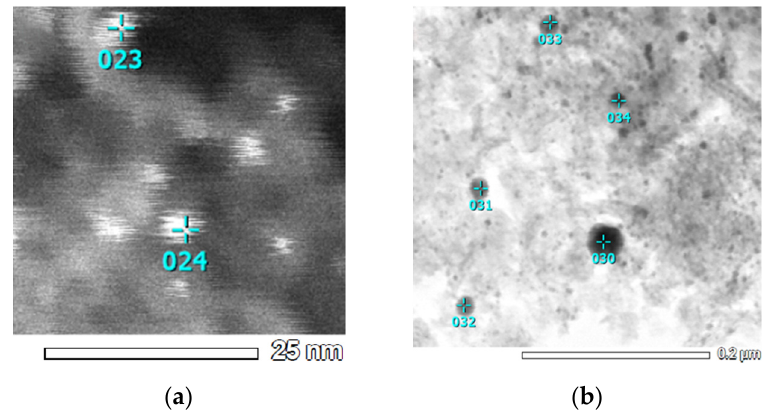
Figure 5. Pointlike scanning of the sample surface of the catalyst PdBi/Al 2 O 3 by EDS at magnification of ( a ) 2,000,000× and ( b ) 400,000 × .